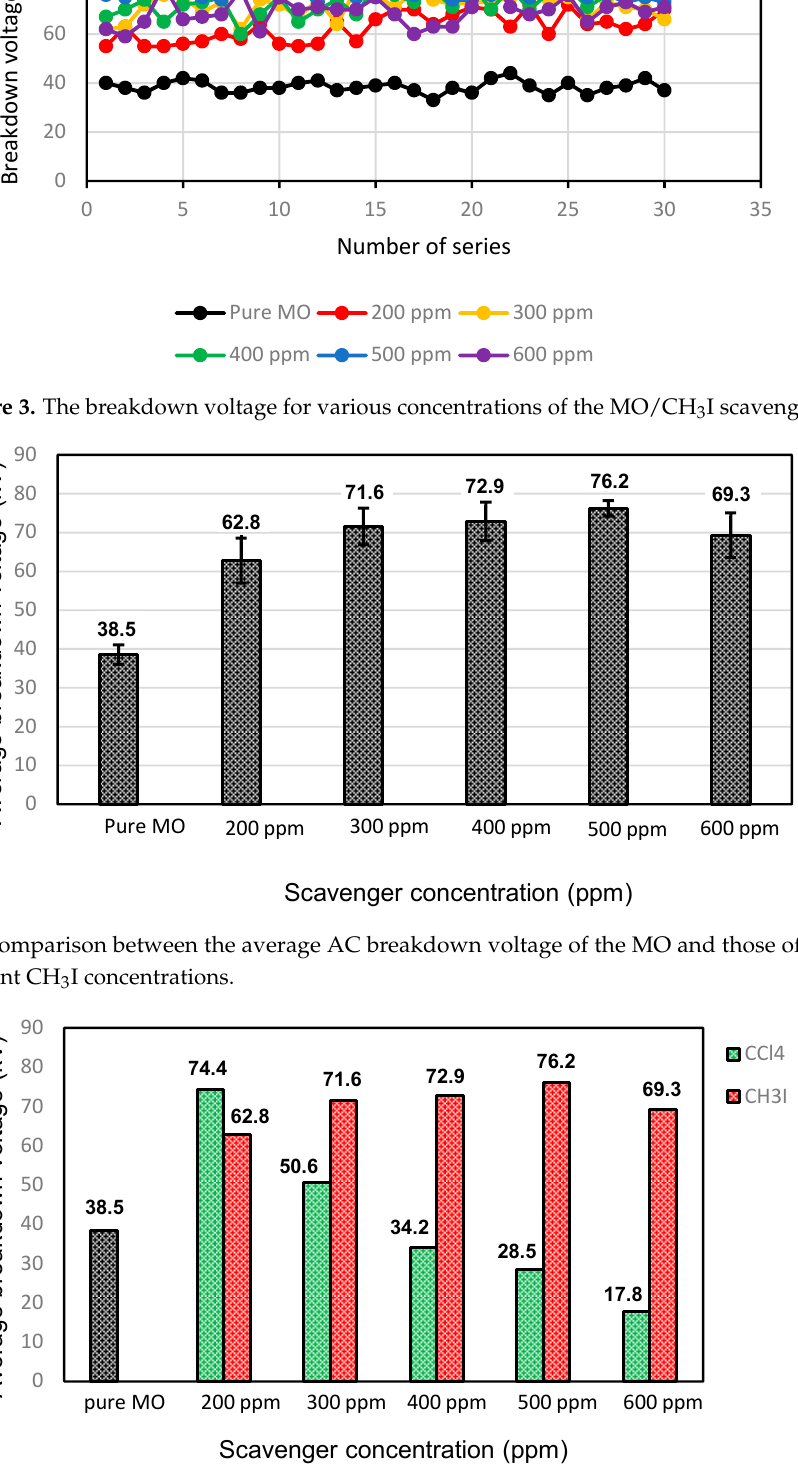
Figure 5. Comparison between the CCl 4 and CH 3 I additives in the MO.